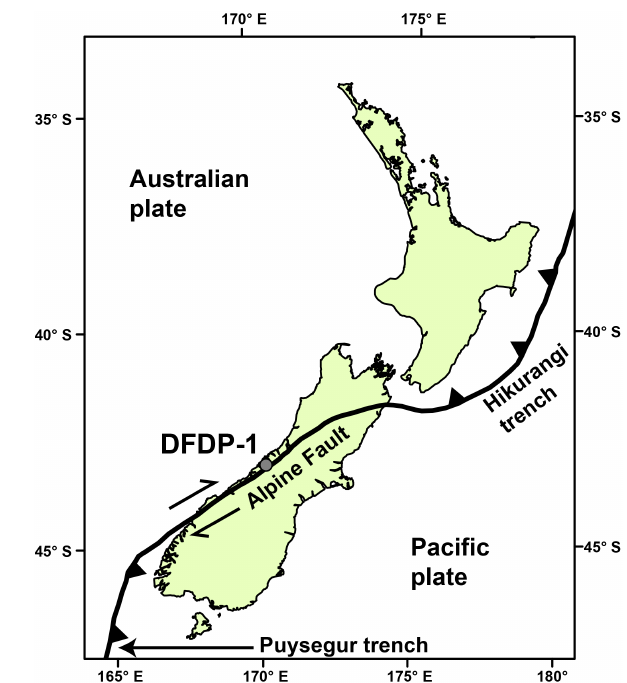
Figure 1. Location of the Alpine Fault and the DFDP-1 boreholes in the context of the Australian–Pacific plate boundary through New